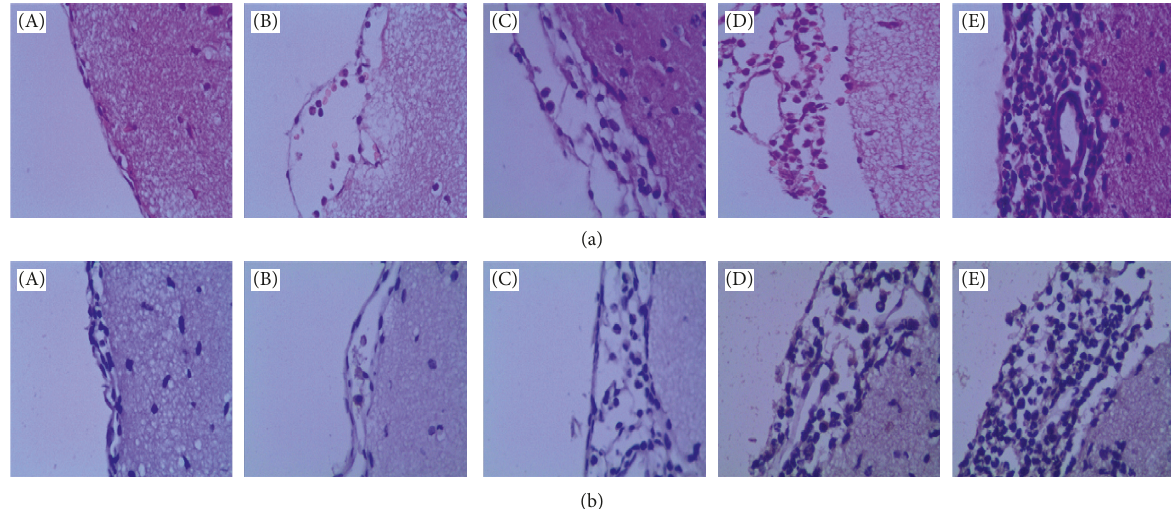
Figure 3: Hematoxylin/eosin-stained and immunohistochemical staining sections ( of Streptococcus pneumoniae meningitis rats by the HE staining method. (b) The meningeal structural change of Streptococcus pneumoniae meningitis rats detected by the immunohistochemical method. (A) Control group, (B) 12h group, (C) 24h group, (D) 48h group, and (E) 7d group.